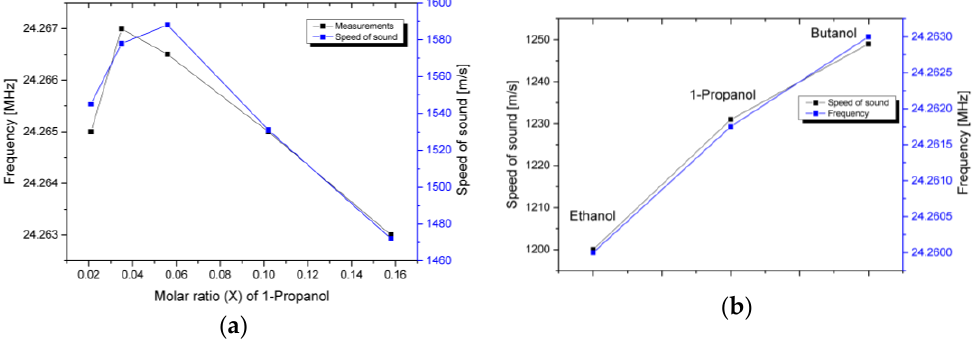
Figure 6. ( a ) Dependence of the transmission minima on the speed of sound of a binary mixture of water and 1-propanol for a molar fraction range of 0.021–0.158 [27]; ( b ) Dependence of the transmission minima on the speed of sound of standard alcohols (ethanol, 1-propanol, butanol) [27].